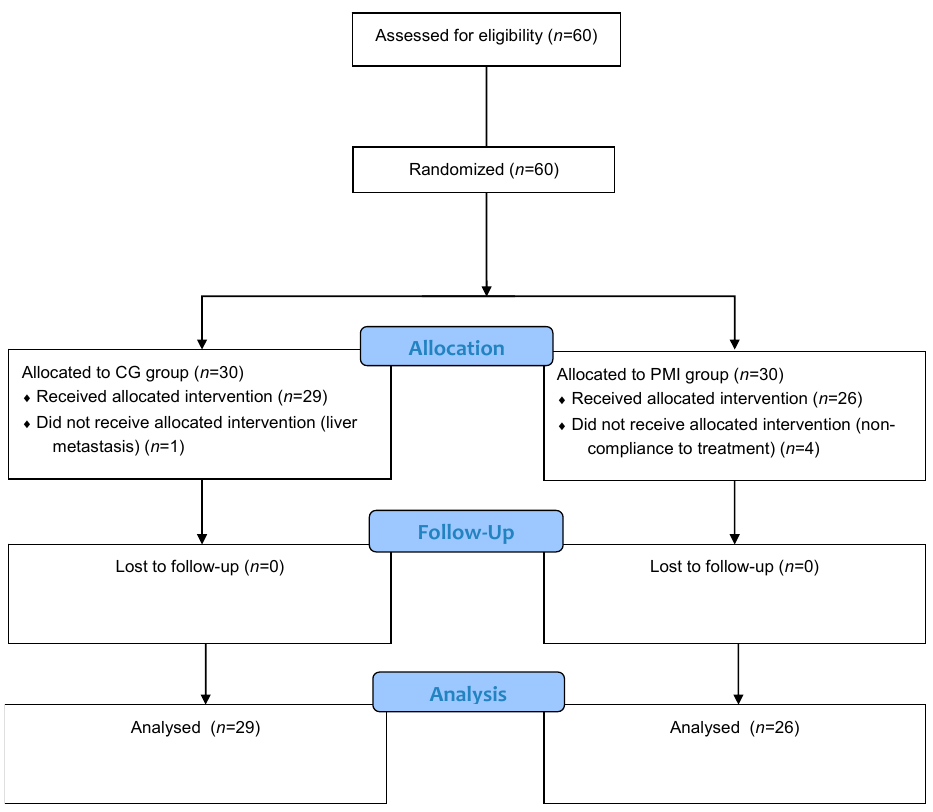
Figure 1. Randomized Clinical Trial profile. PMI: psychotherapy with music intervention group; CG: treatment as usual group.